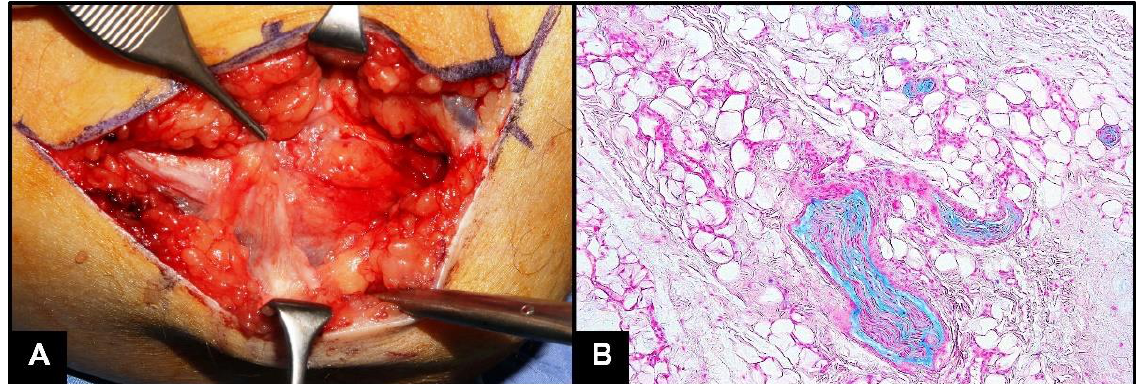
Figure 1. ( A ). Macroscopic intraoperative photography showing ulnar nerve entrapment at the left elbow (cubital tunnel syndrome). ( B ). On microscopy, histochemistry for Alcian Blue reveals in light blue myxoid degeneration of the small nerve collaterals (20x objective).